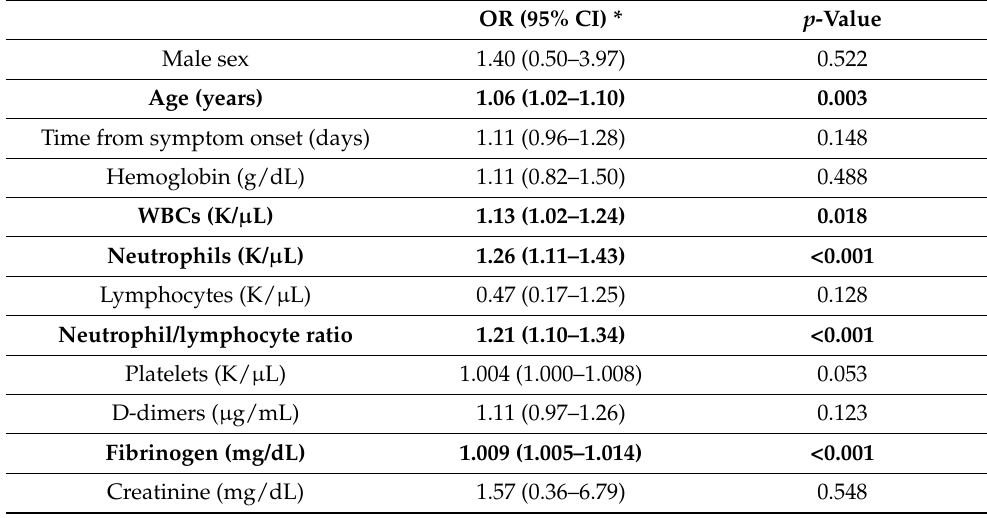
Table 2. Univariable association of age, sex and baseline laboratory parameters with critical COVID-19 in the absence of comorbidities (derivation